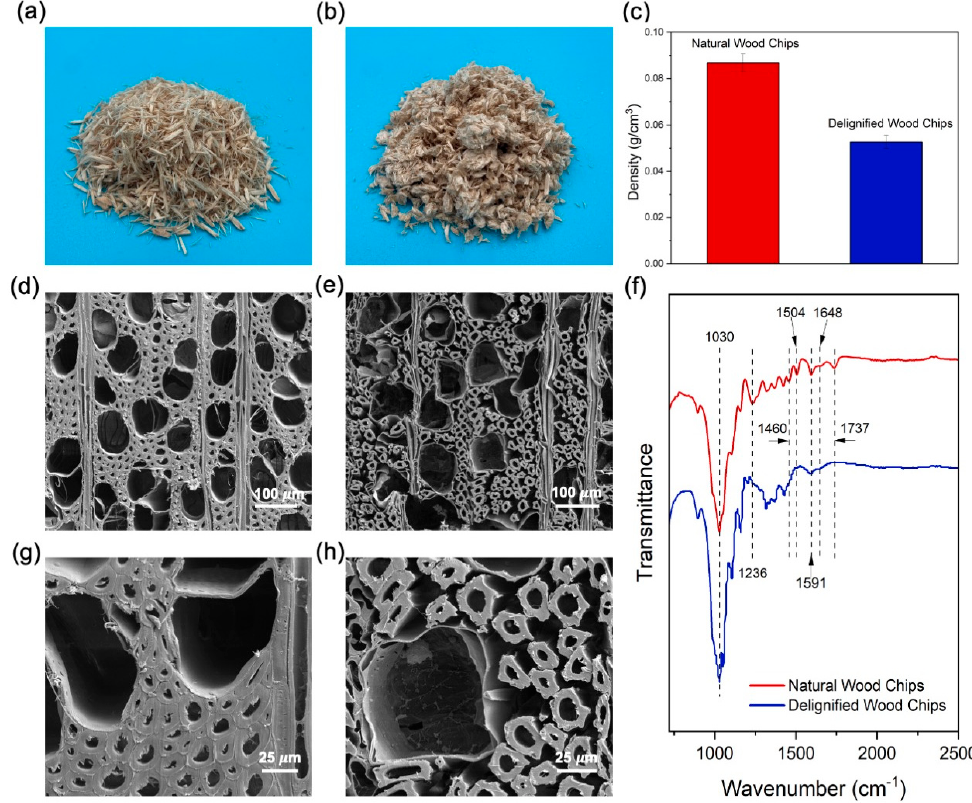
Figure 2. Structural and compositional characterization. ( a ) Natural and ( b ) delignified wood chips. ( c ) Density comparison of natural and delignified wood chips. SEM images of ( d ) natural and ( e ) delignified wood chips. ( f ) FTIR spectra. Magnified SEM images of ( g ) natural and ( h ) delignified wood